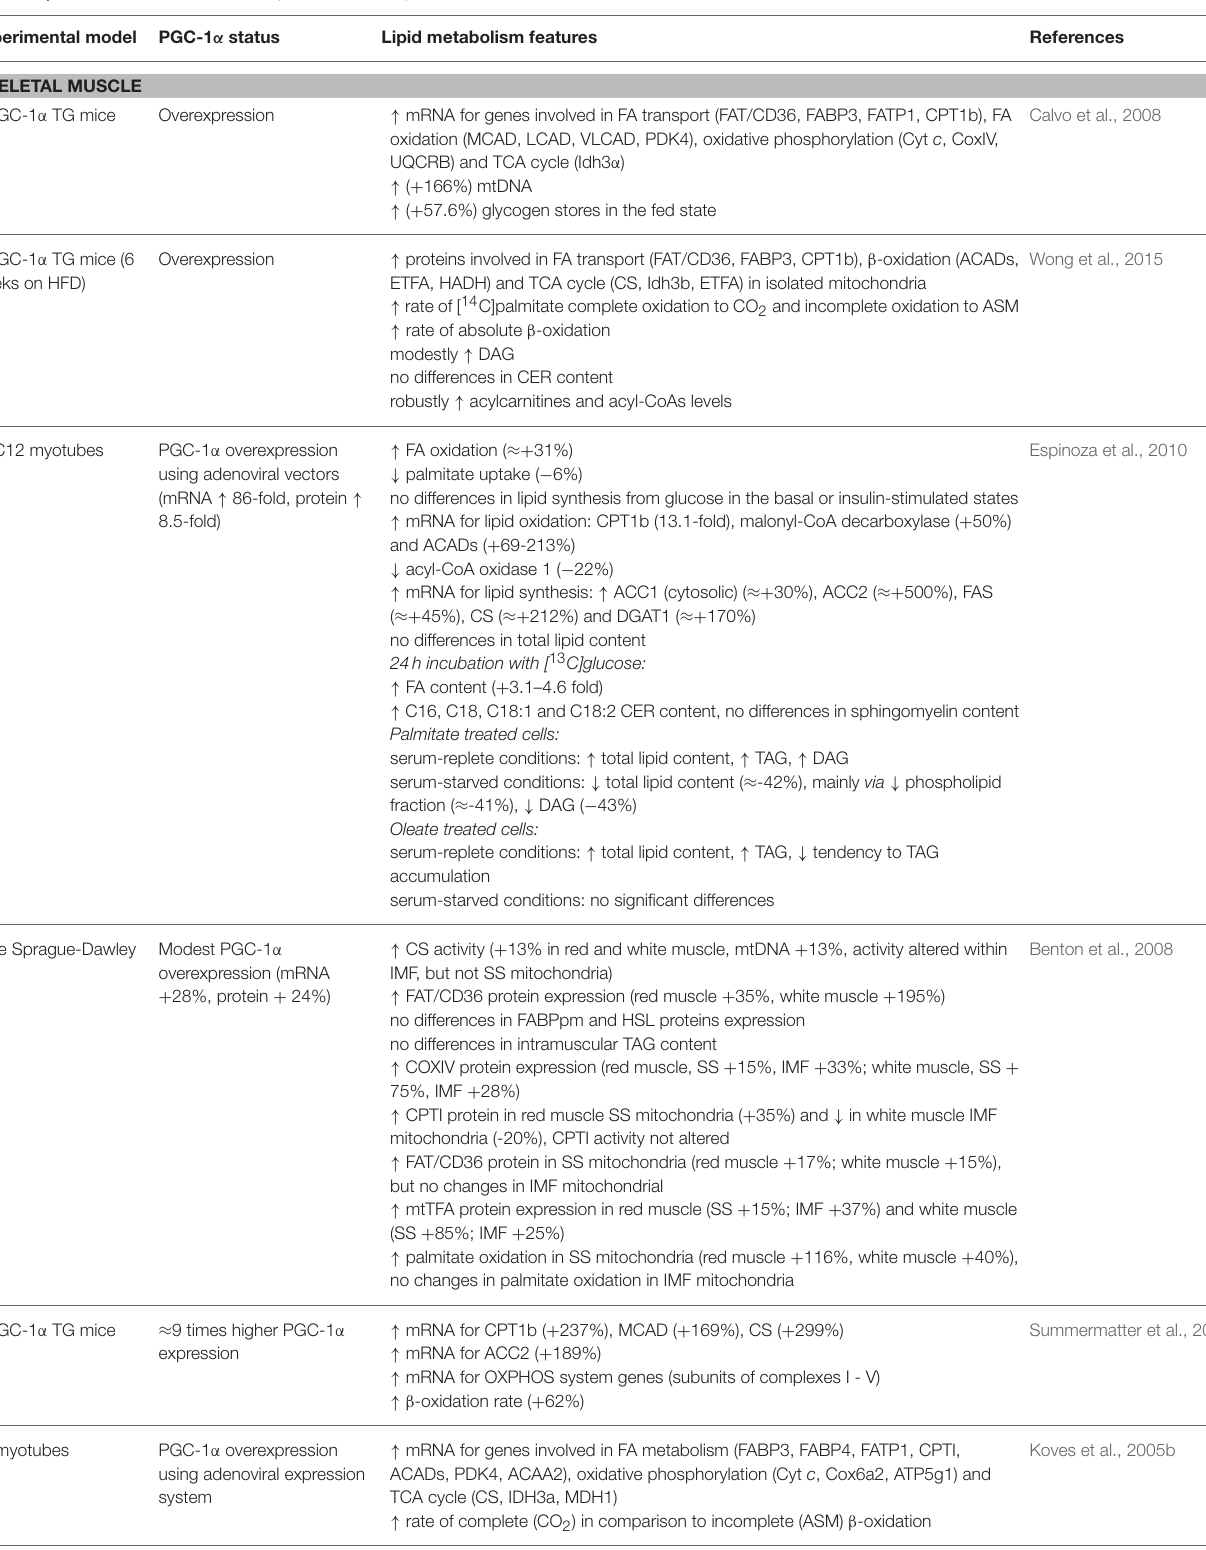
TABLE 1 | The effects of PGC-1 α overexpression on the lipids